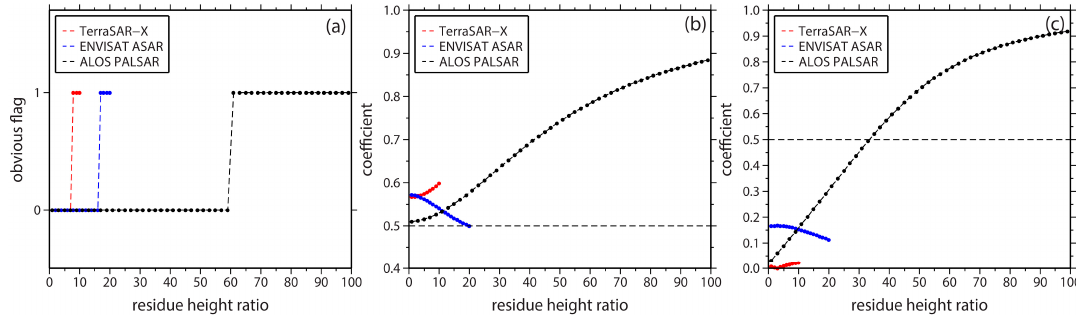
Figure 5. ( a ) The significance test of deformation rate difference between h_ratio > 1 and h_ratio = 1 for three different platforms. Value 1 means the significance test is passed while value 0 means the opposite. ( b ) The relationship between mean deformation rate accuracy and topographic residuals precision for every h_ratio value. The y-axis is the correlation of two factors for every h_ratio . ( c ) The relationship between time-series deformation RMSE and topographic residuals precision for every h_ratio value. The y-axis is the correlation of two factors for evey h_ratio . The red, blue and black dashed lines represent the results of TerraSAR-X, ENVISAT ASAR and ALOS/PALSAR, respectively.